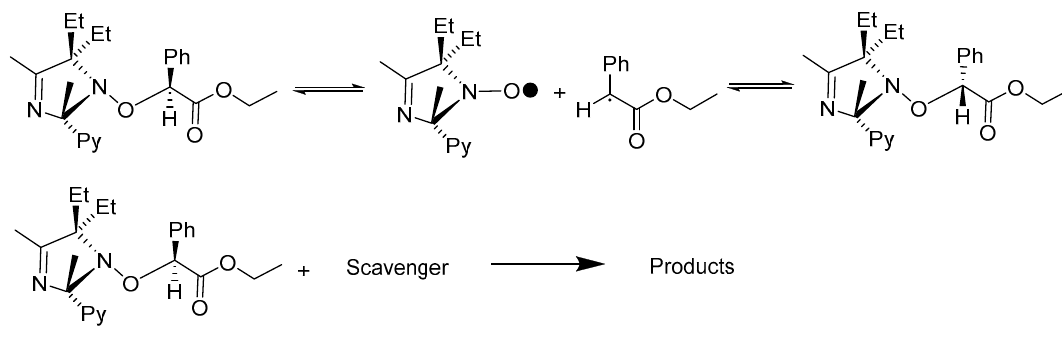
-1000/T Figure 3. Eyring plot for the nitrogen inversion of the 2 RS/SR diastereomer.